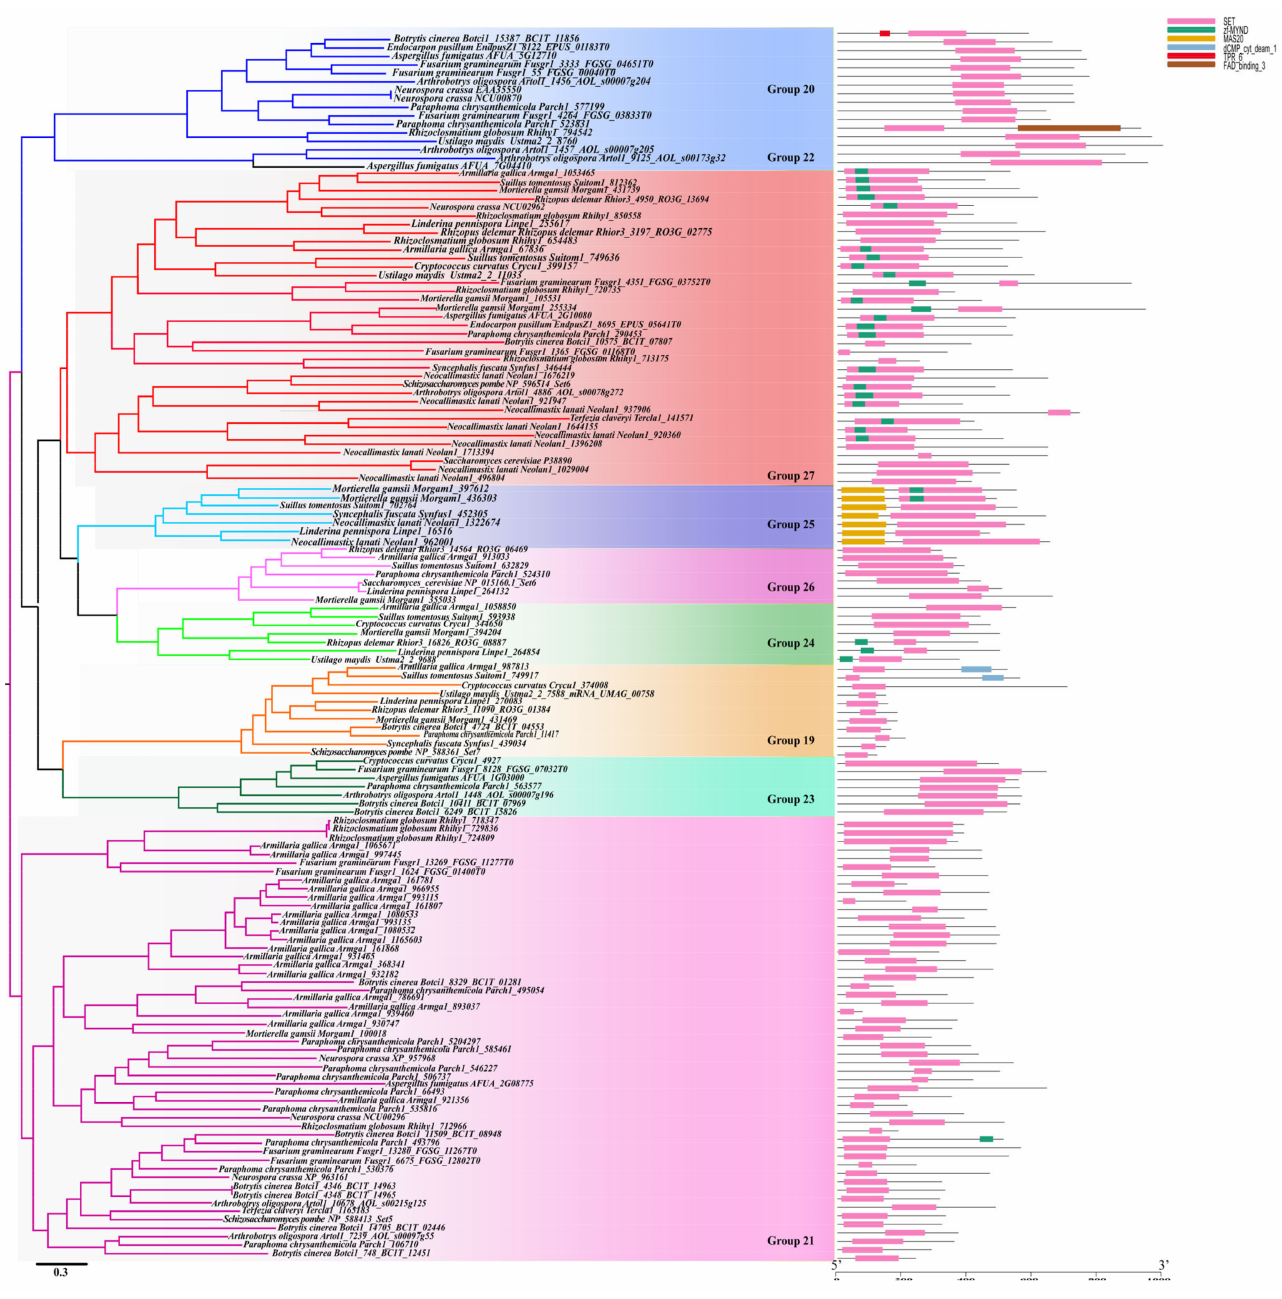
Figure 7. Phylogenetic analysis and domain organization of the Cluster 3 SET domain sequences from 20 representative 20 fungal species. The protein domains were labeled with different colors based on the domain type. Domain organization of SET domain containing proteins were detected by the InterProScan 5.0 (http://www.ebi.ac.uk/interpro/) and MEME suite (https://meme-suite. org/meme/) with default parameter settings. Phylogenetic analyses were performed using NJ with MEGA X and ML analysis with